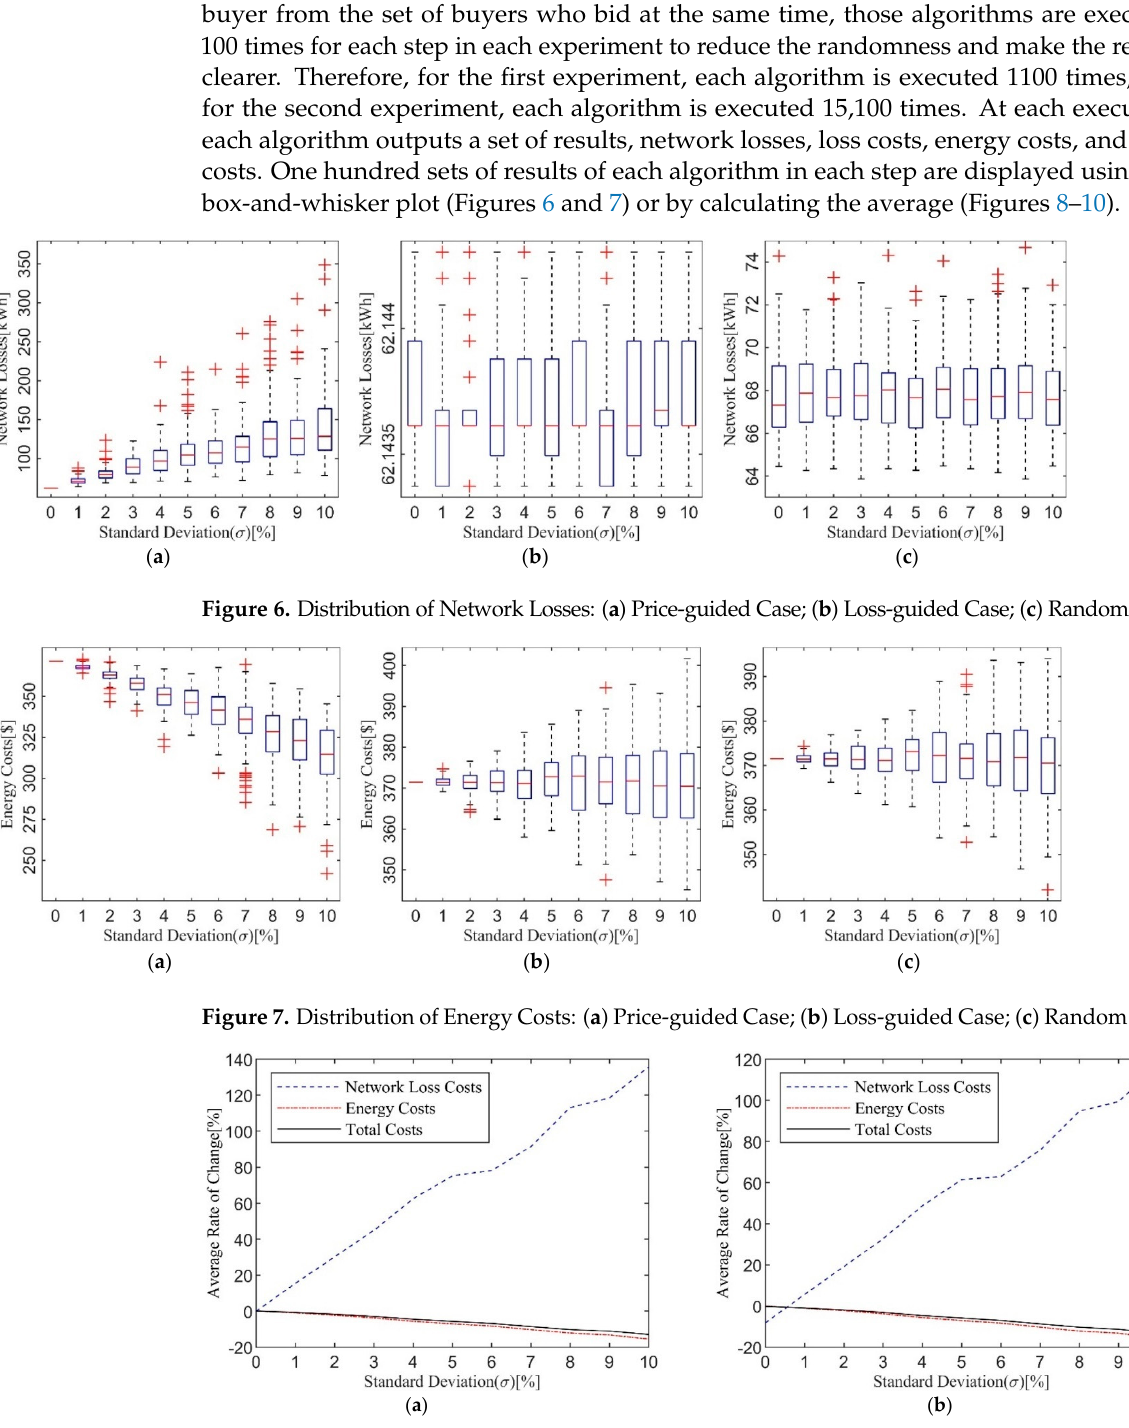
Figure 8. Average Rate of Change in Costs between ( a ) Price-guided Case and Loss-guided Case; ( b ) Random Transaction Case and Price-guided Case.